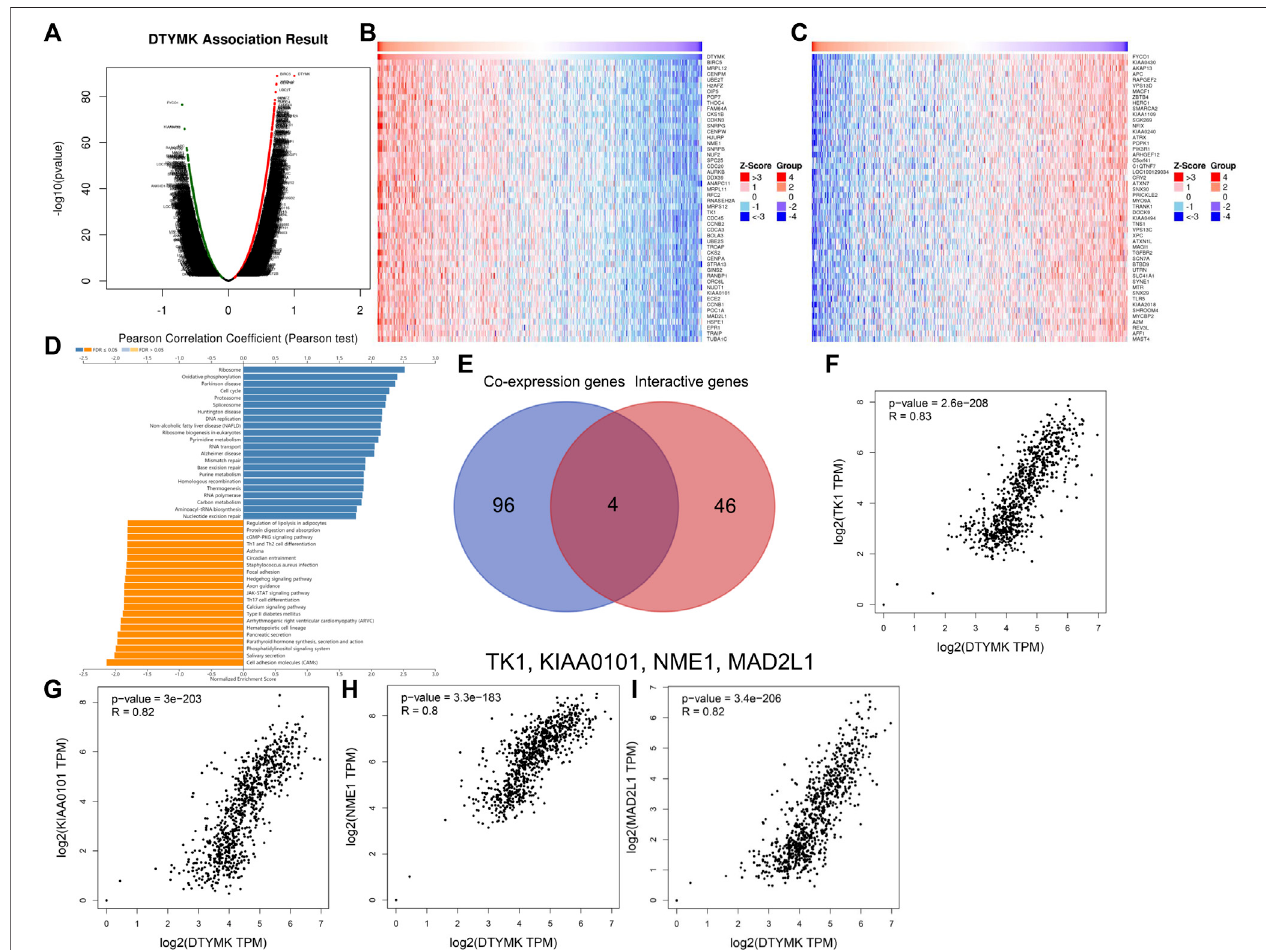
FIGURE 9 | Analysis of DTYMK co-expressing genes in lung adenocarcinoma. (A) DTYMK co-expressing genes are shown by Volcano plot. Top 50 genes that positively (B) and negatively (C) correlated with DTYMK are shown by heatmap plot. (D) Gene Set Enrichment Analysis (GSEA) of DTYMK co-expressing genes. (E) Common genes including thymidine kinase 1 (TK1), proliferating cell nuclear antigen clamp associated factor (KIAA0101), NME/NM23 nucleoside diphosphate kinase 1 (NME1), mitotic arrest de fi cient 2 like 1 (MAD2L1) were obtained by the intersection of DTYMK interactive genes and DTYMK co-expressing genes. The relations between DTYMK expression and TK1 expression (F) , KIAA0101 expression (G) , NME1 expression (H) , MAD2L1 expression (I) were validated by GEPIA database.